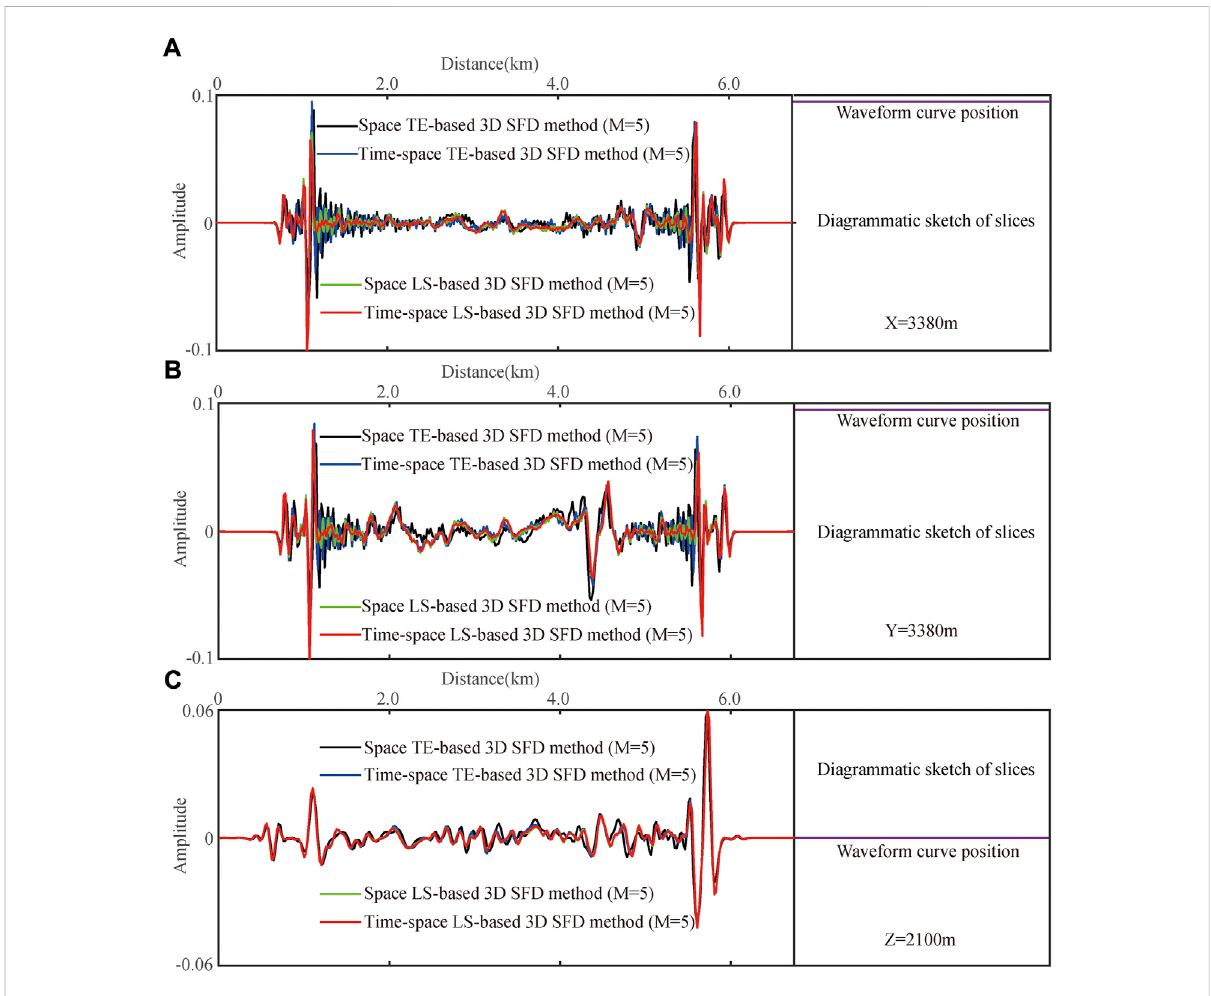
FIGURE 11 Waveform curves of the 2D snapshots ( M (cid:2) 5) shown in Figure 10 and the positions of these waveform curves. (A) Waveform curves of the 2D snapshots at x (cid:2) 3380m. (B) Waveform curves of the 2D snapshots at y (cid:2) 3380m. (C) Waveform curves of the 2D snapshots at z (cid:2)